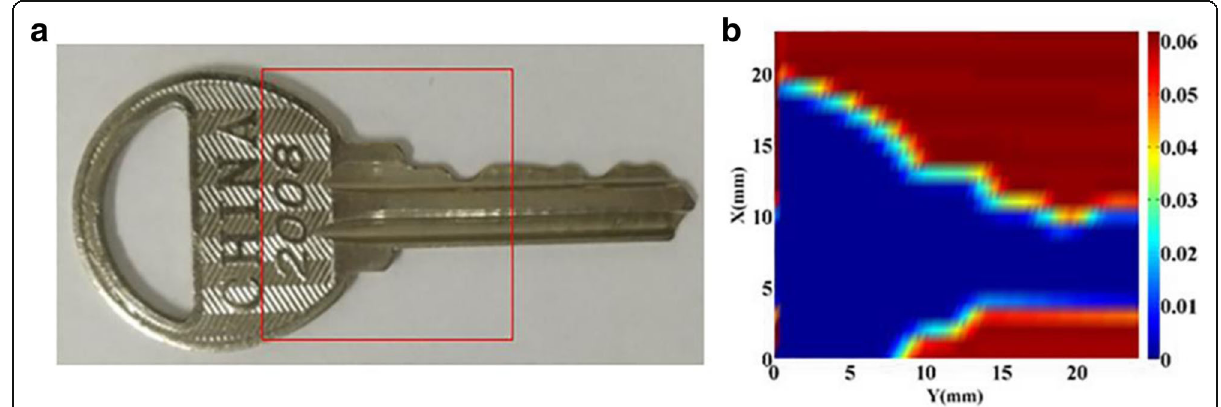
Fig. 7 Comparison of a metal key between a the optical picture and b the terahertz